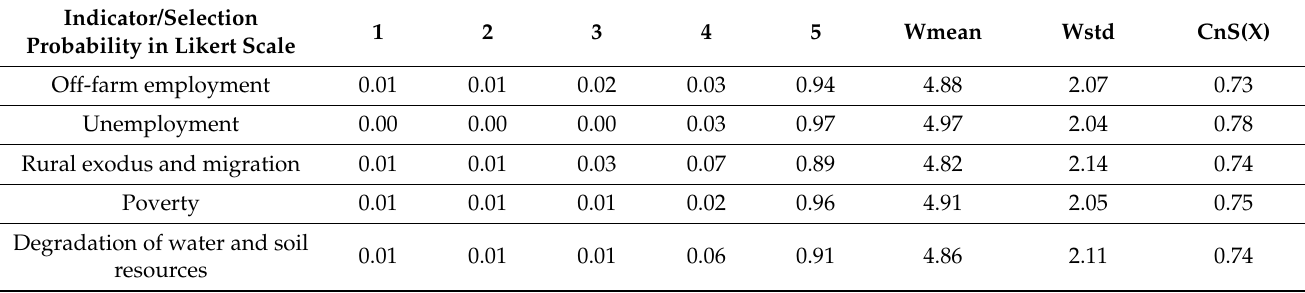
Table 9. Impacts of land use/land cover changes perceived by